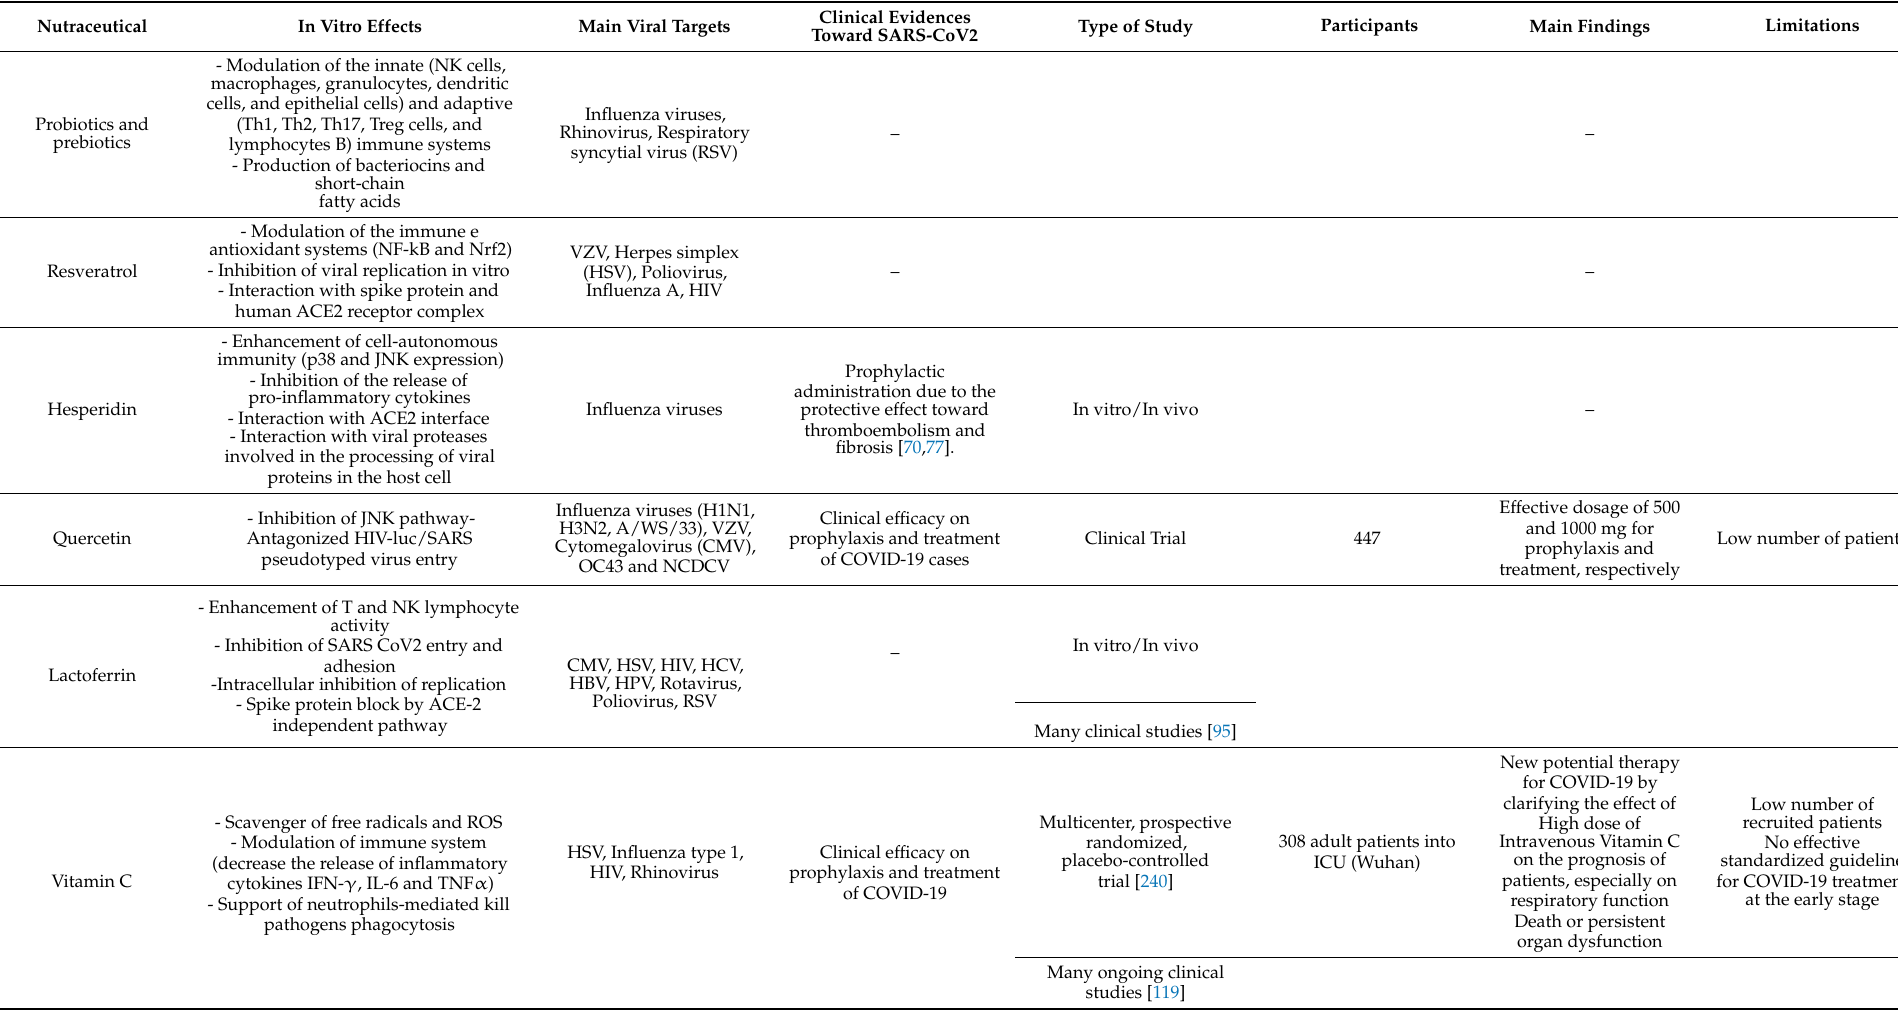
Table 1. Nutraceuticals, relative antiviral properties, and eventual clinical evidence on